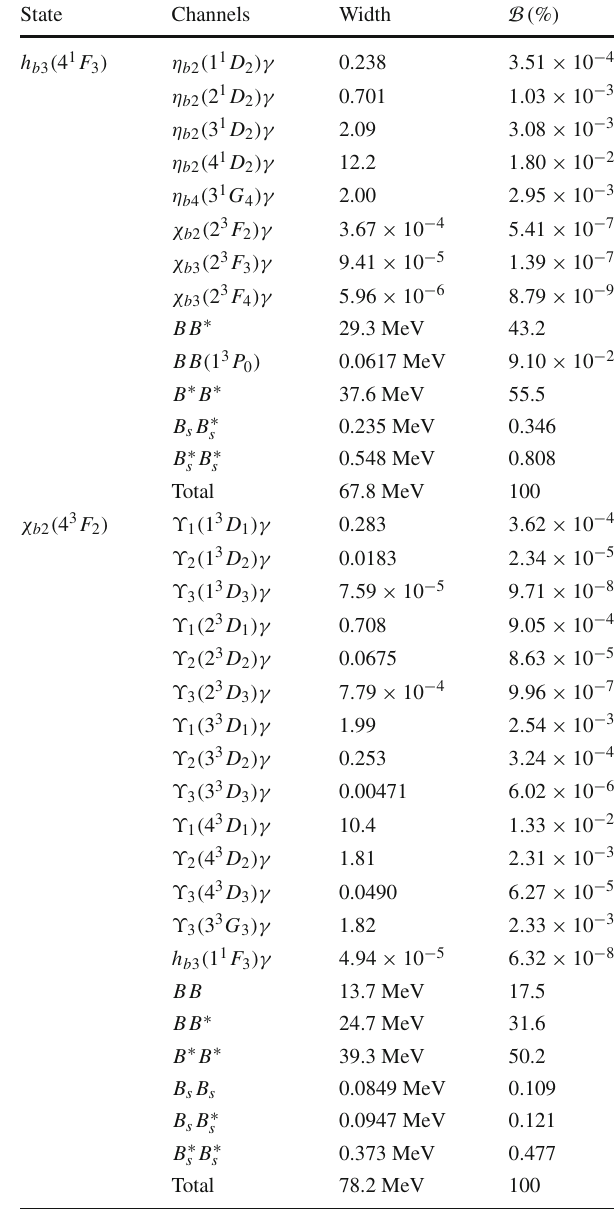
Table 35 Partial widths and branching ratios of OZI-allowed strong decay, annihilation decay, and radiative transition and the total widths for 3 3 F 3 and 3 3 F 4 bottomonium states. The width results are in units of keV